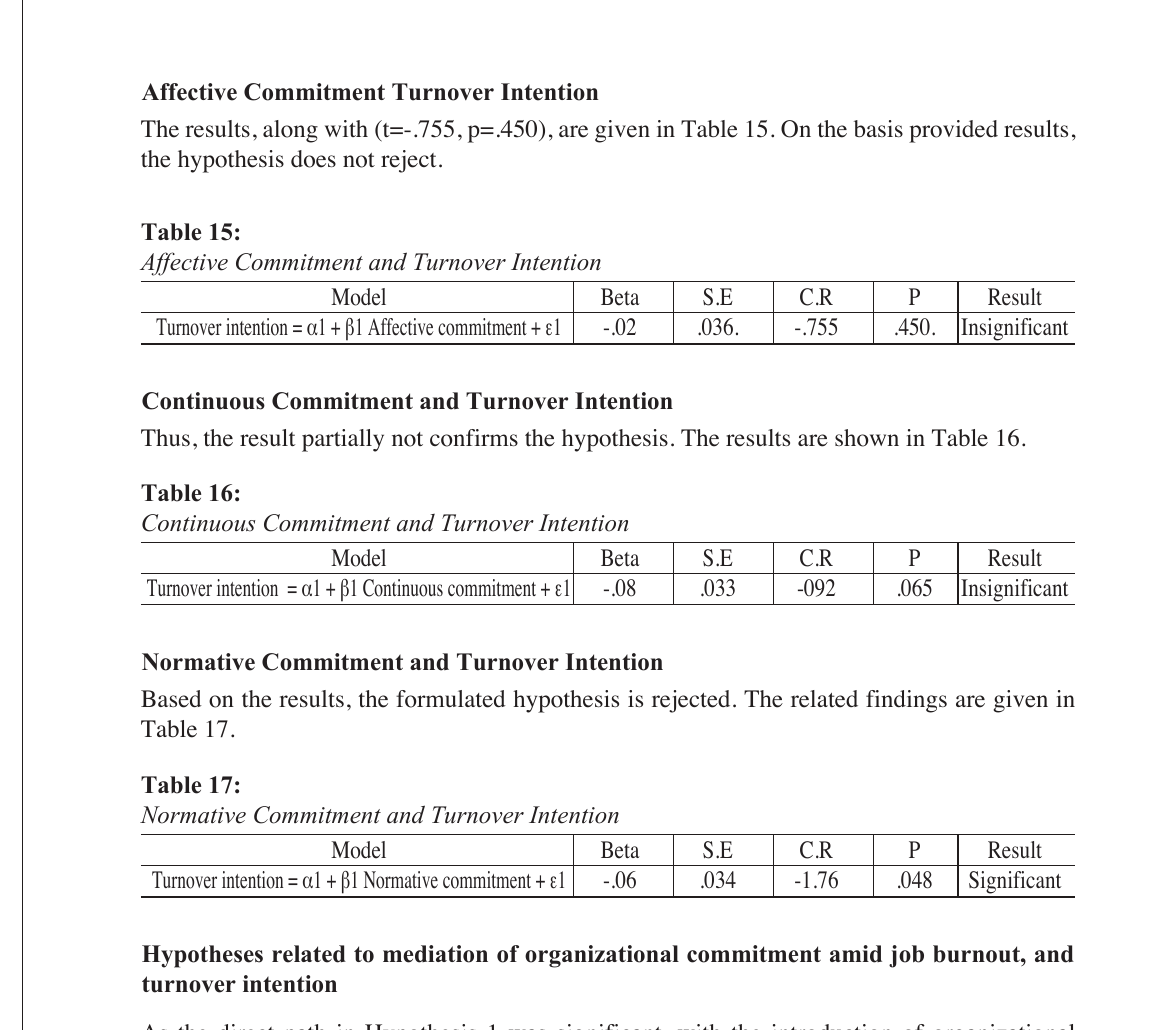
Affective Commitment Turnover Intention